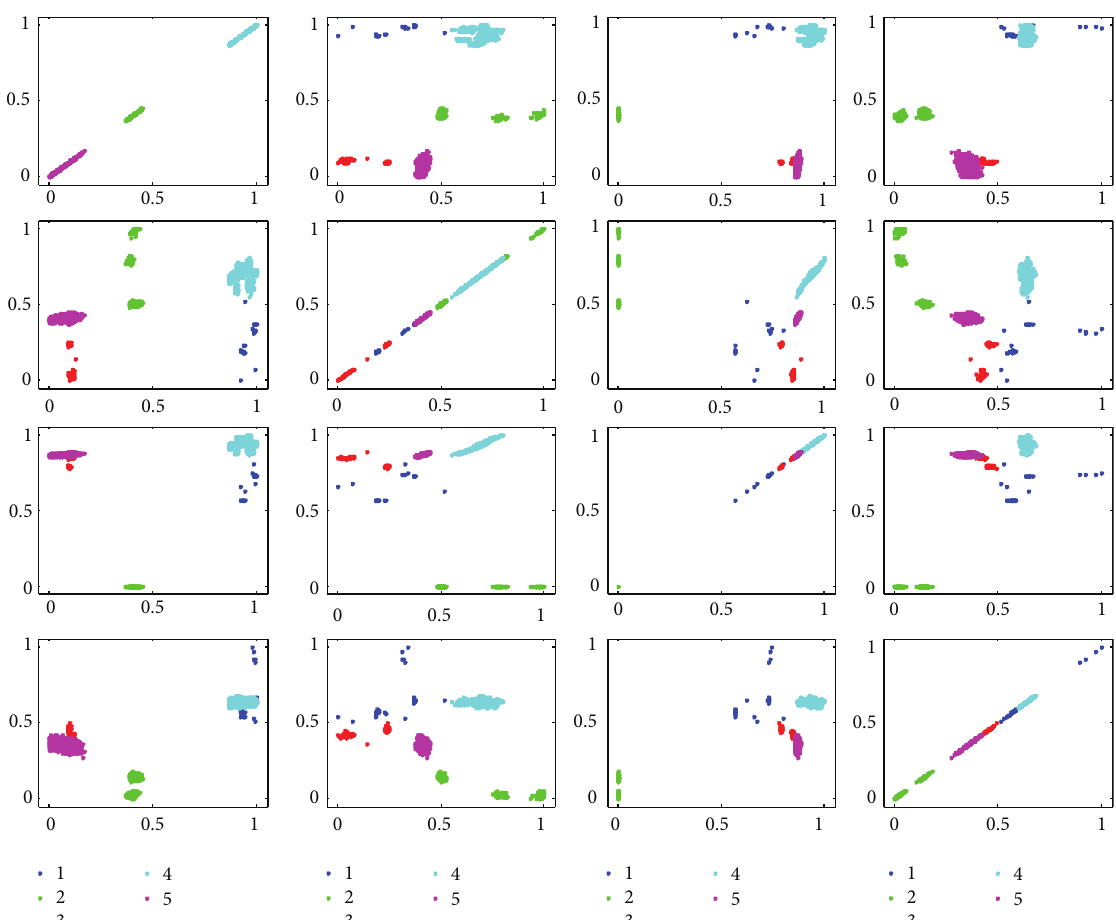
Figure 15: Scatter in 2D space expended with feature pairs selected by kernelized mutual